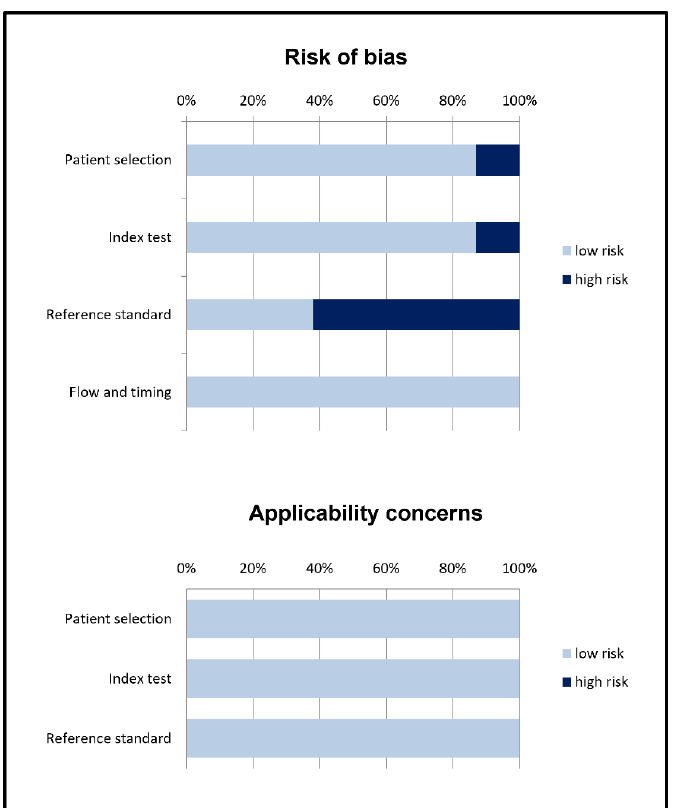
Figure 2. Summary of quality assessment according to QUADAS-2 tool. Studies included in the systematic review are classified as low-risk or high-risk of bias or applicability concerns for different domains (reported in the vertical axis). The horizontal axis indicates the percentage of studies. The graph indicates that for the reference standard more than half of the studies show potential high risk of bias.